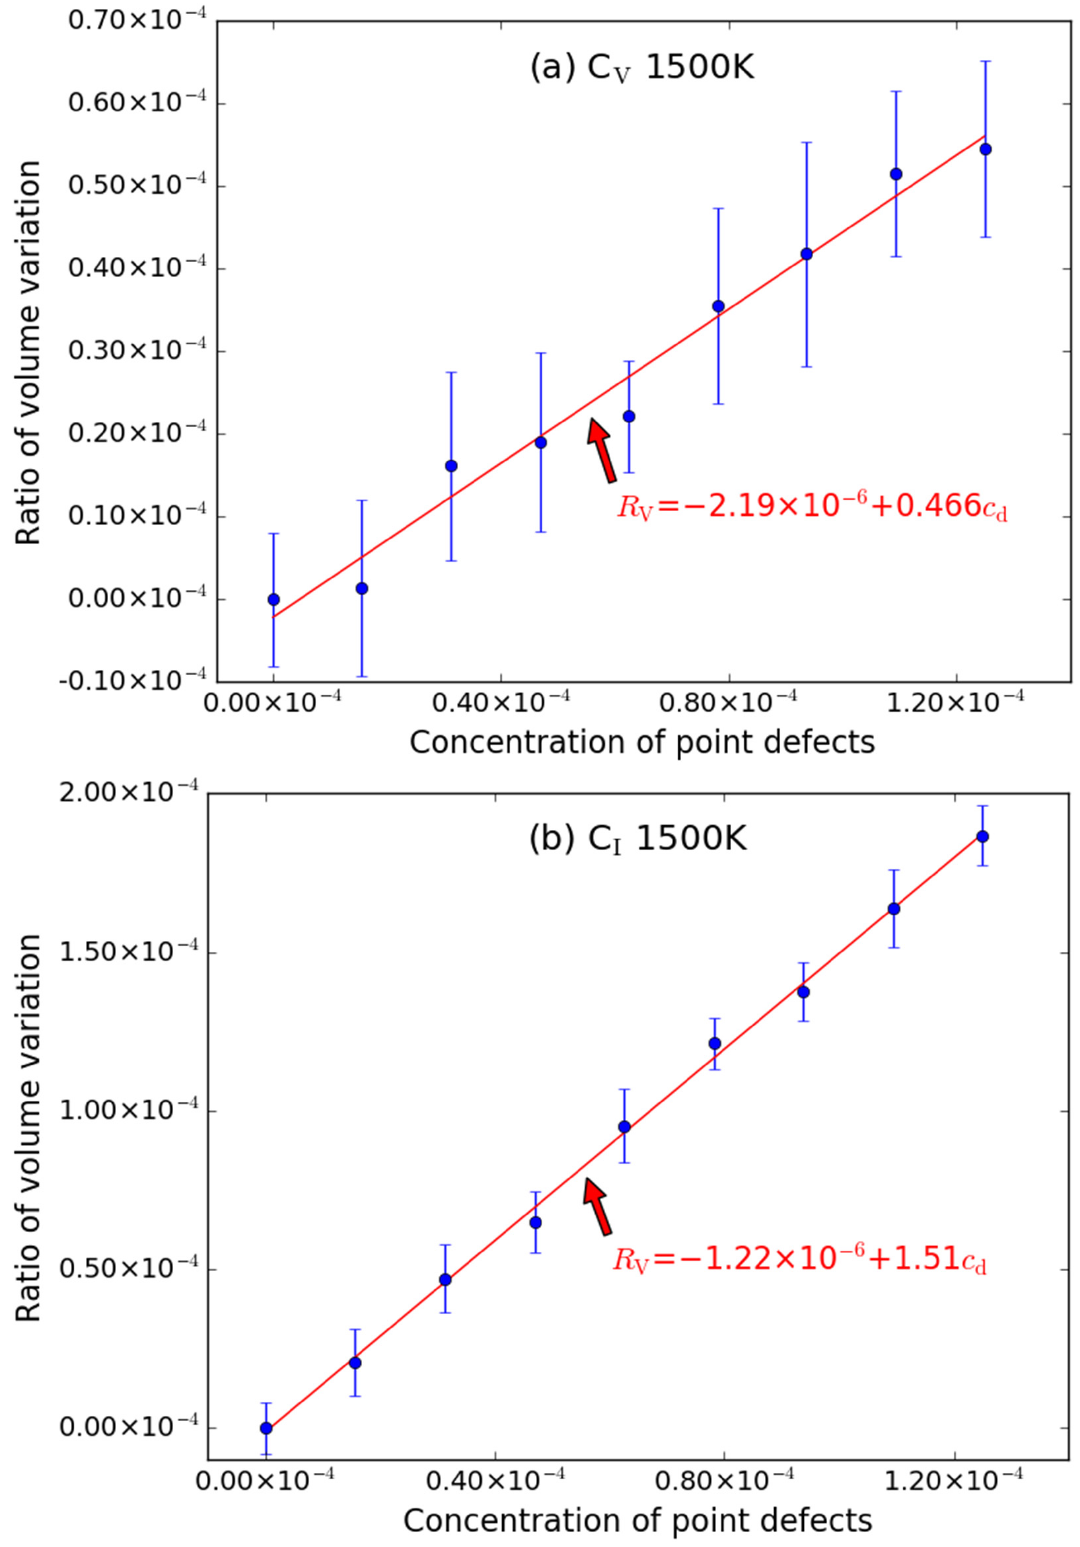
Figure 5. The ratio volume variation ( R V ) of the supercell caused by C-type point defects (( a ) C V and ( b ) C I ) as function of concentrations ( c d ) of point defects at 1500 K. The error bars denote the standard deviations of the values. The size of supercell in MD simulation is 20 a × 20 a × 20 a .